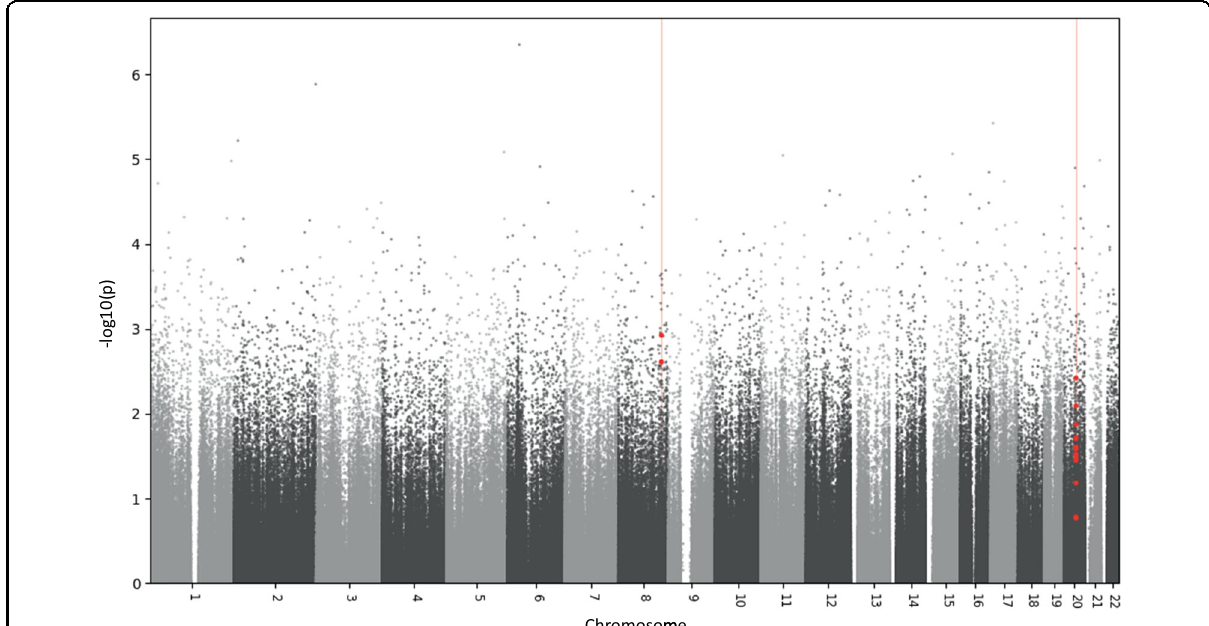
Fig. 1 Manhattan plot of differentially methylated regions for Δ HDRS. Signi fi cantly differentially methylated regions associated with the effect of Δ HDRS are indicated in red (chromosomes 8 and